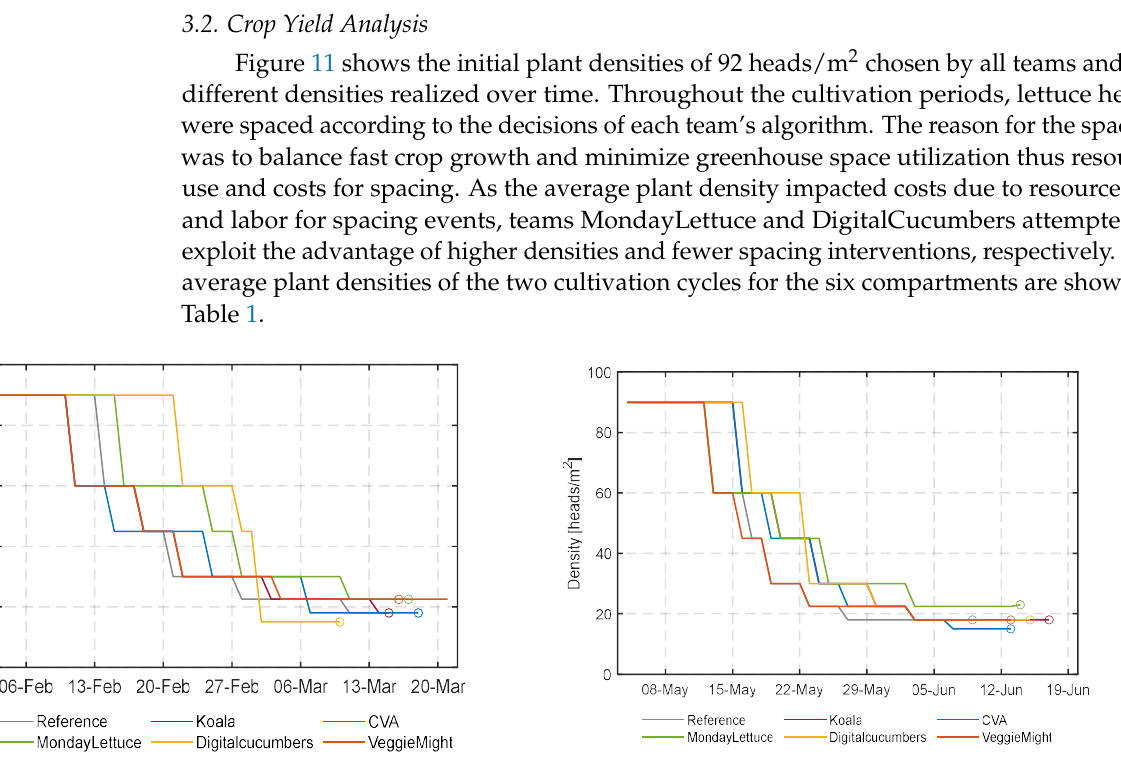
Figure 11. Lettuce density (heads m 2 ) and harvest dates (o) in the different compartments during the first and second cultivation period.